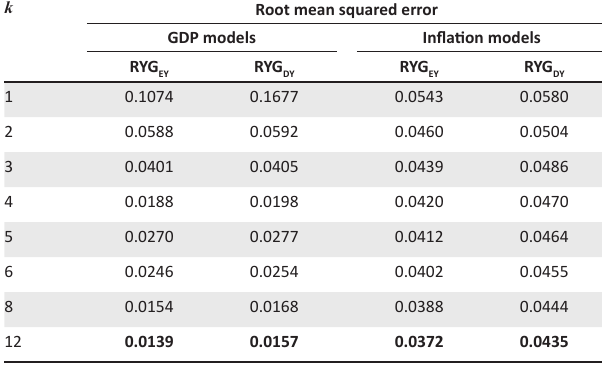
TABLE 5: Out-of-sample forecasting results. k Root mean squared error GDP